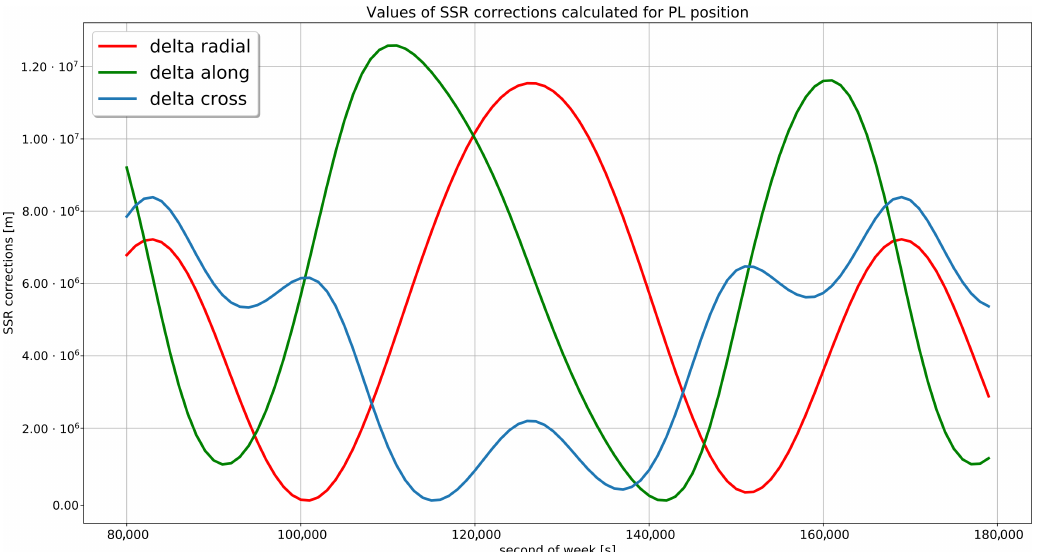
Figure 3. Minimized values of SSR corrections for pseudolite 24-h positioning session.